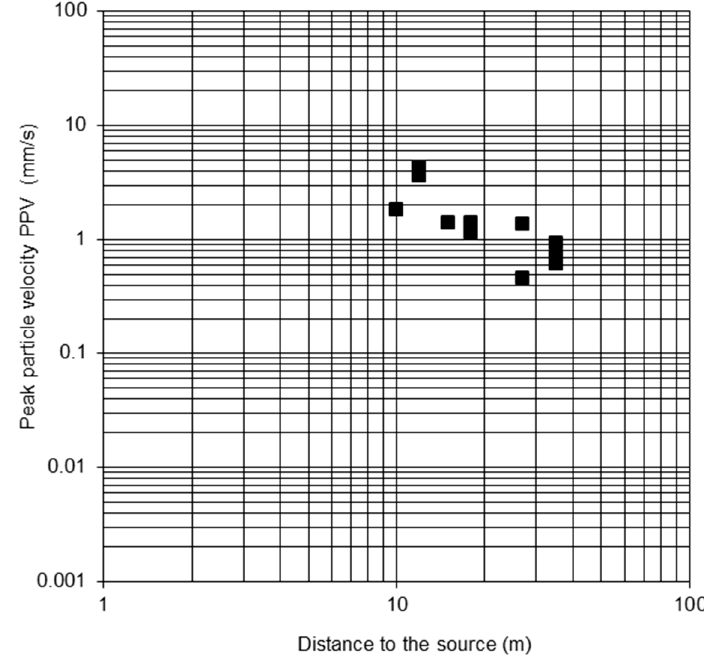
Figure 5. Logarithmic graph of the ripping with vibration.